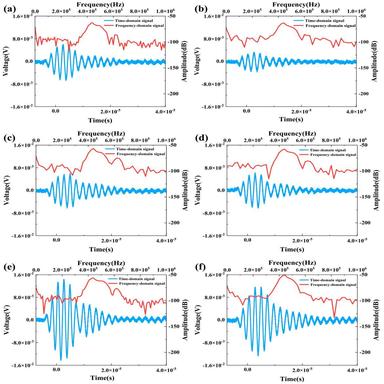
Received signal diagram of the ultrasonic transducers with varying pore sizes of MCE (a) No MCE, (b) 0.22 μm, (c) 0.45 μm, (d) 0.65 μm, (e) 0.8 μm, (f) 1.2 μm.